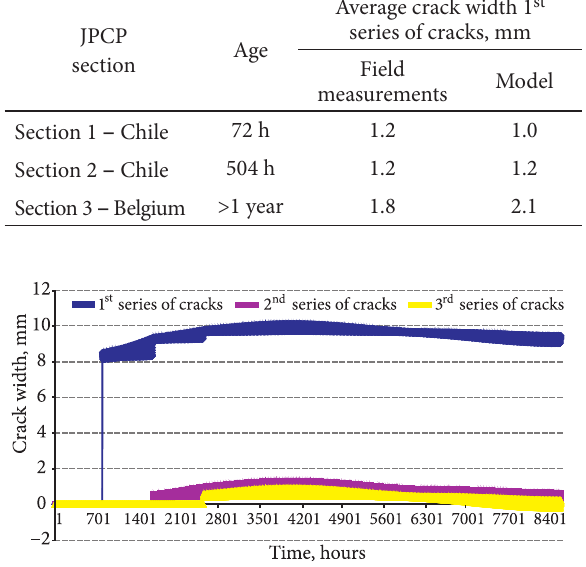
Fig. 5. Development of transverse cracks width during 1